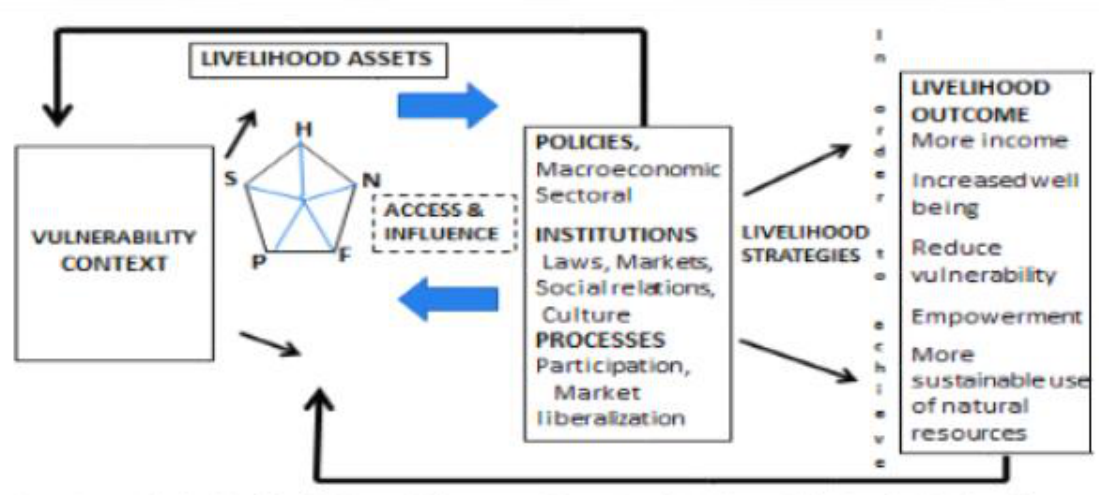
Fig. 2: Sustainability livelihood framework developed by DFID (1999)